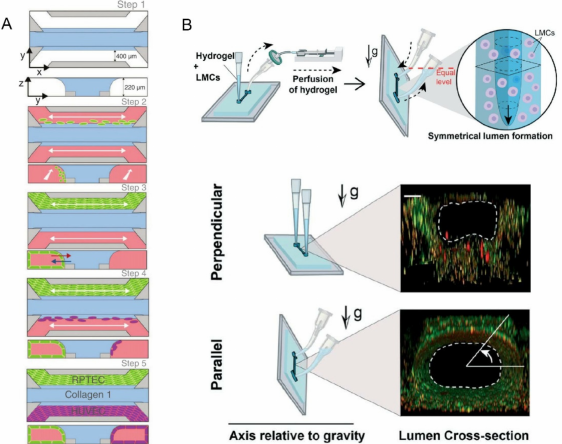
Figure 5. ( A ) The blue area was a liquefied ECM gel composed of type 1 collagen. The green and purple areas were tubules formed by human RPTEC and HUVEC. Reprinted with permission from Ref. [54]. Copyright 2022 American Society of Nephrology. ( B ) GLP technique to fabricate